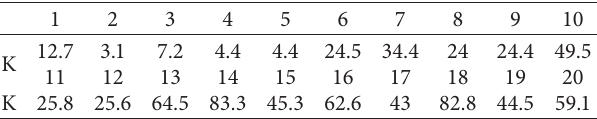
Table 7: Distance A ik from different donation groups to the blood centre (unit: km).